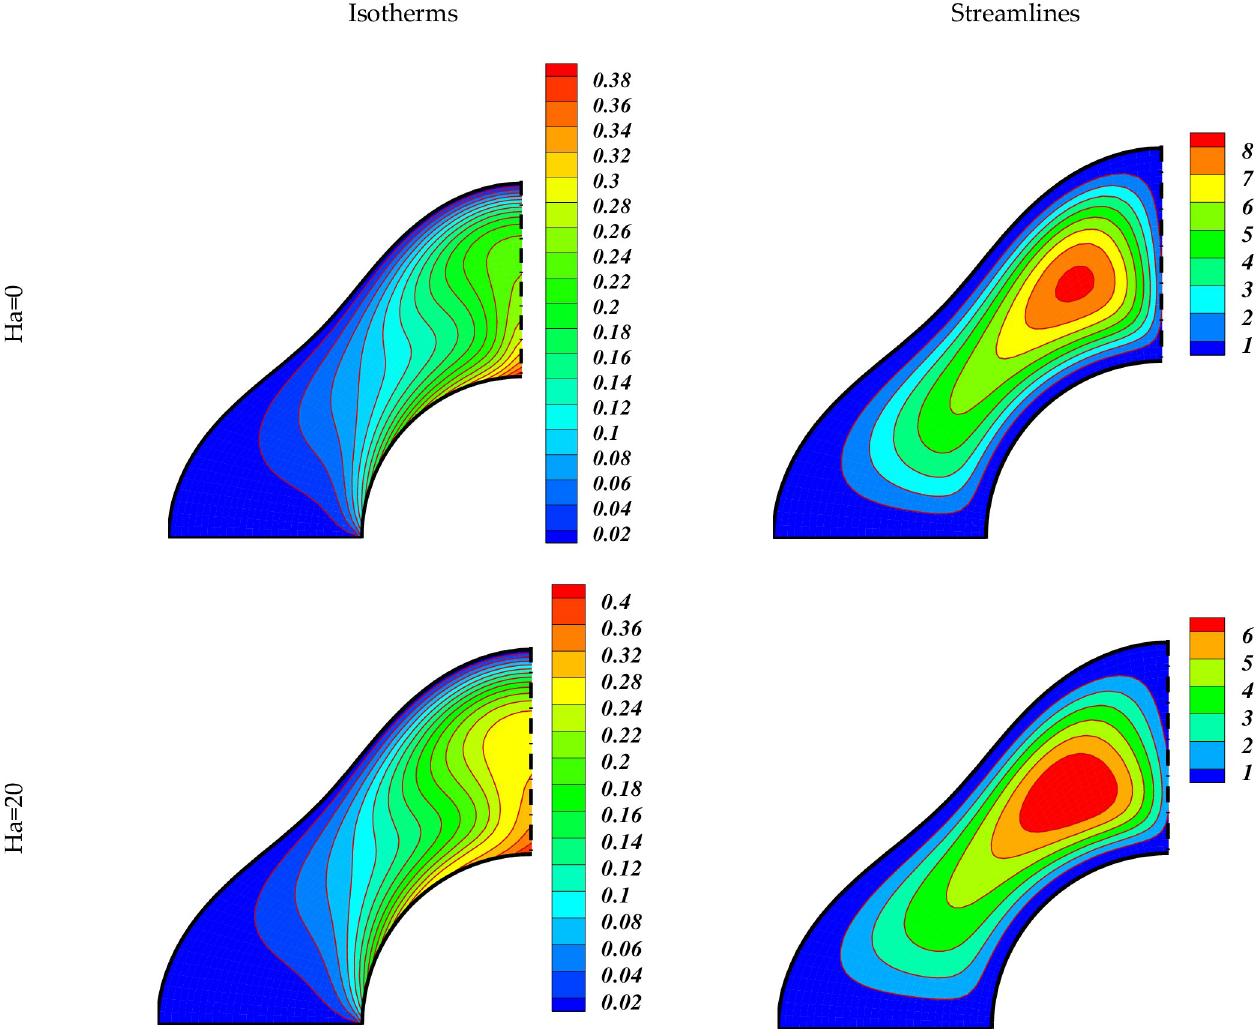
Fig 4. Impact of Ha on the flow when Ra = 10 5 , Rd = 0 . 8 , Da = 0 . 01